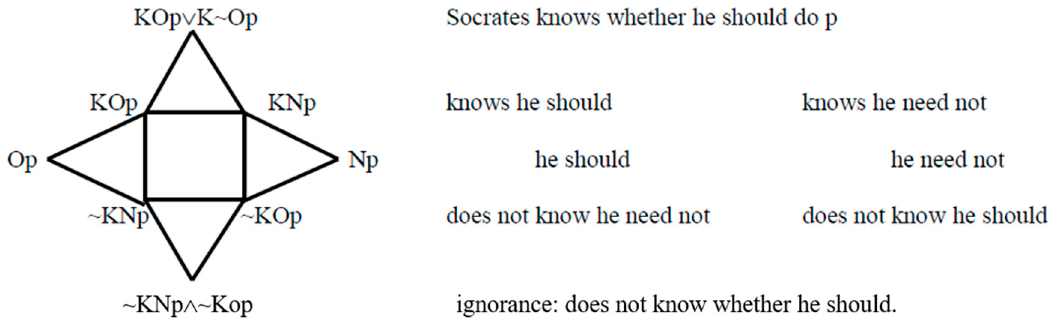
Figure 10. The octagon with the deontic operator O.